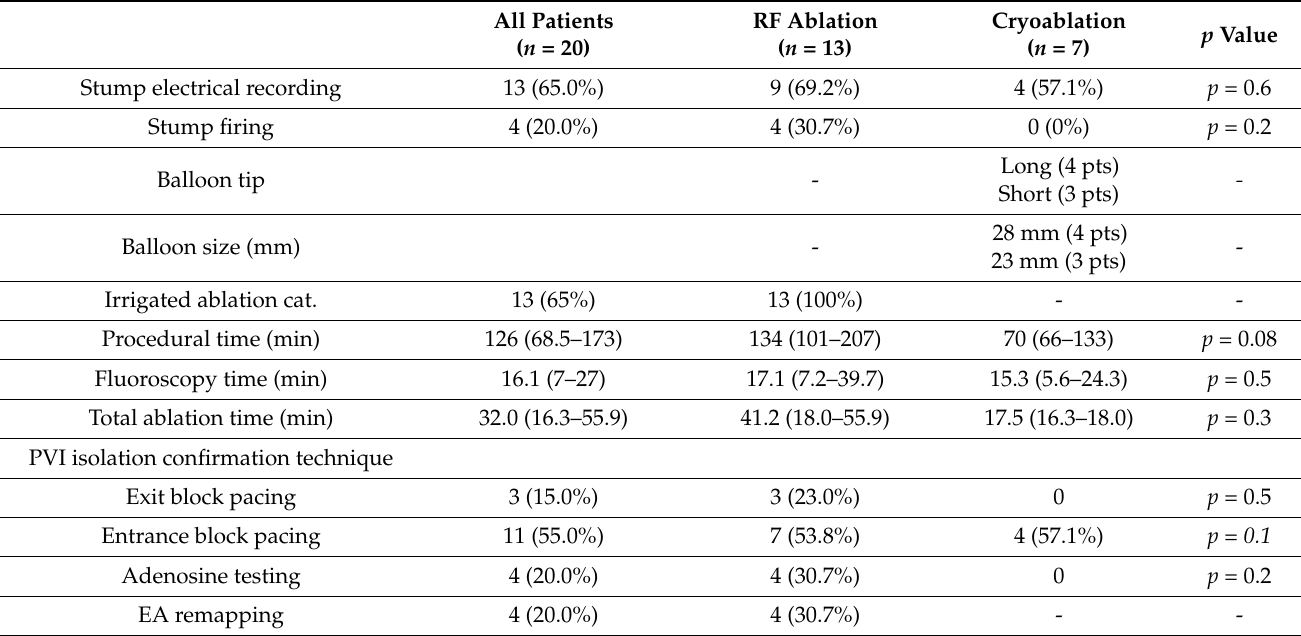
Table 2. Differences in procedural characteristics between patients treated by means of radiofrequency pulmonary vein isolation or